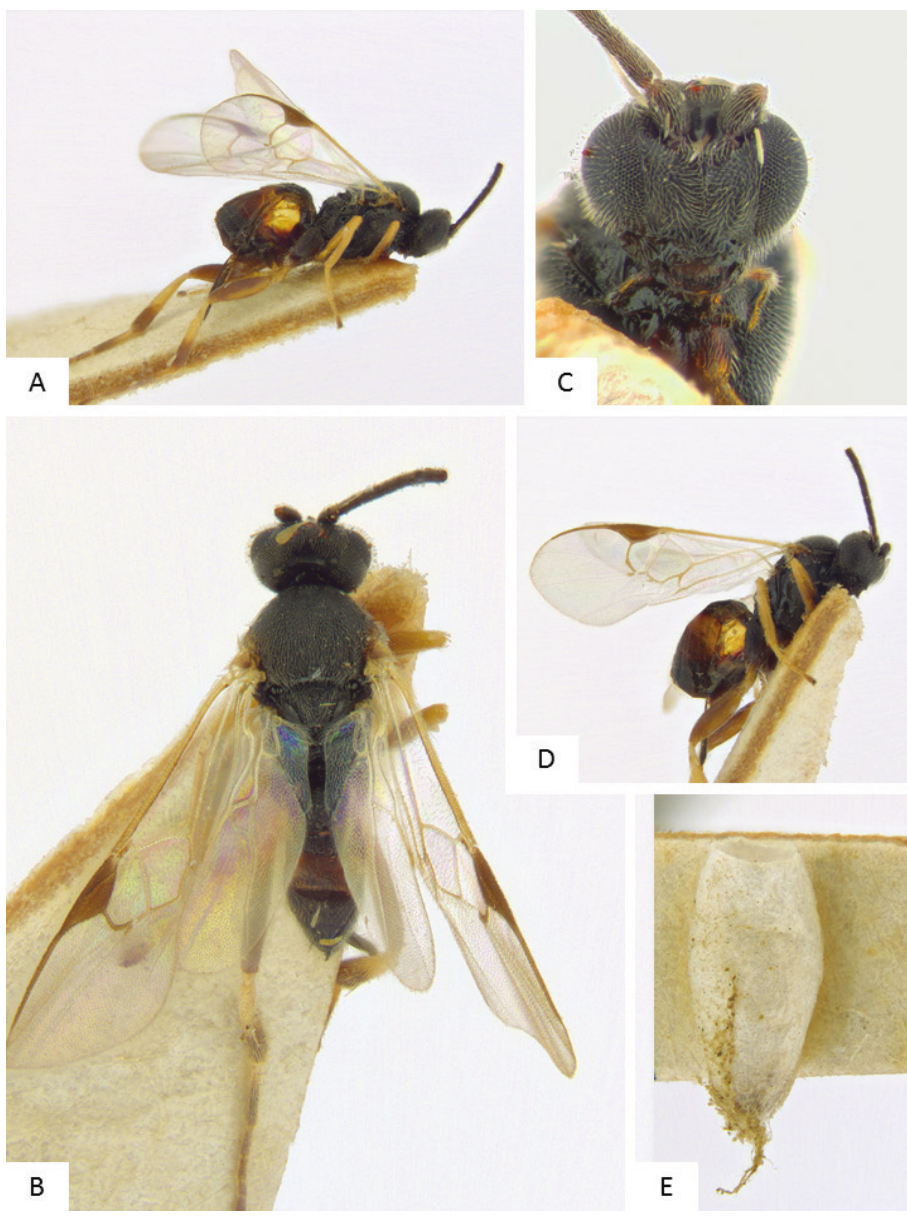
Figure 4. Apanteles hemara , female holotype from